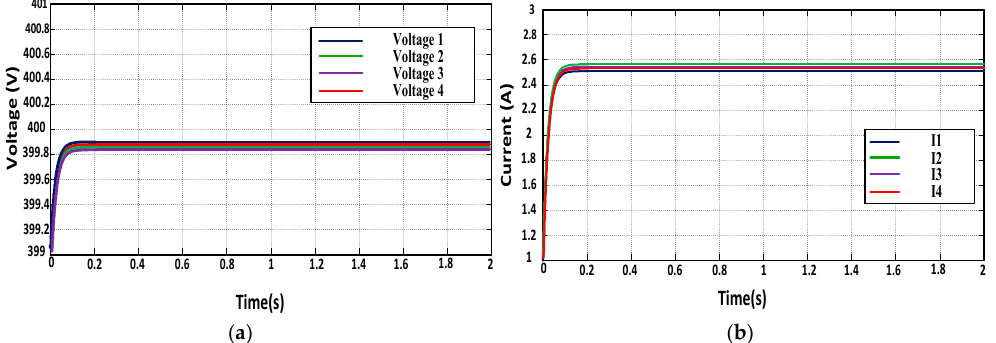
Figure 10. Existing technique [13] with ring communication structure. ( a ) Voltage waveform, ( b ) Current waveforms.